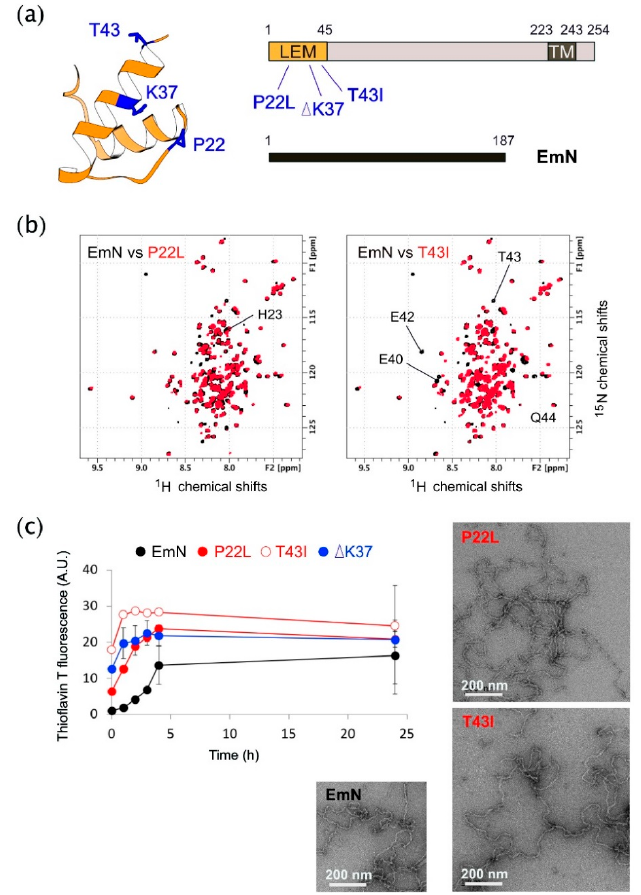
Figure 1. The three emerin mutations associated with cardiac defects favor emerin self-assembly in vitro. ( a ) Emerin structure. Left panel: Ribbon diagram of emerin LAP2-emerin-MAN1 (LEM)-domain in orange with proline 22, lysine 37 and threonine 43 in blue. Right panel: Representation of full length emerin (residues 1–254), and the fragment EmN (residues 1–187). Full length emerin is composed of 254 residues. It exhibits an N-terminal 45-residue LEM-domain, including P22, K37 and T43, a transmembrane domain (residues 223–243) and a C-terminal luminal domain (residues 244–254). ( b ) Impact of LEM domain mutations on emerin conformation in solution. Superimposition of the 2D NMR 1 H- 15 N HSQC spectra of wild-type EmN (in black) with mutants P22L (left panel) or T43I (right panel), both in red. All spectra were recorded at 30 ◦ C, 750 MHz and 150 µ M. The spectra of the two mutants nicely overlay with that of EmN wild-type. The few shifted peaks, corresponding to H23 in P22L, and E40, E42, T43 and Q44 in T43I, are indicated. ( c ) EmN and variants self-assembly kinetics. Left panel: Thioflavin T (ThT) fluorescence was measured as a function of the incubation time at 37 ◦ C for EmN wild-type, P22L, ∆ K37 and T43I (black, filled red, blue and open red symbols, respectively). All proteins were at a concentration of 300 µ M during the kinetics and 20 µ M during the fluorescence measurements. Right panel: Self-assembled P22L and T43I (500 µ M) were heated for 1 h at 65 ◦ C, then incubated for one week at 20 ◦ C. Analysis by negative stain imaging demonstrates the formation of curvilinear filaments of 10 nm diameter. A negative-staining image of filaments obtained from EmN is displayed for comparison. Scale bar, 200